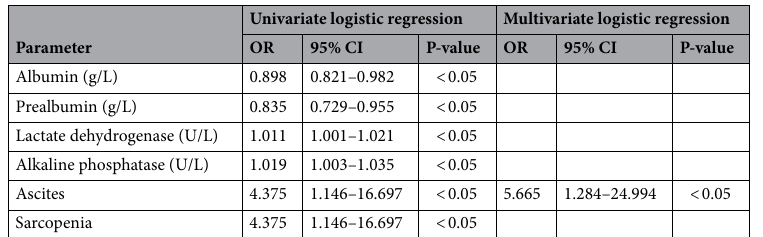
Table 5. Univariate and multivariate logistic regression analyses for malnutrition